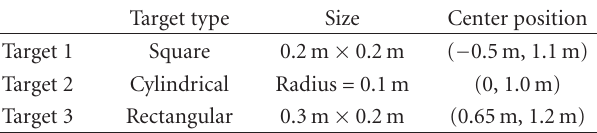
Table 1: Target spatial